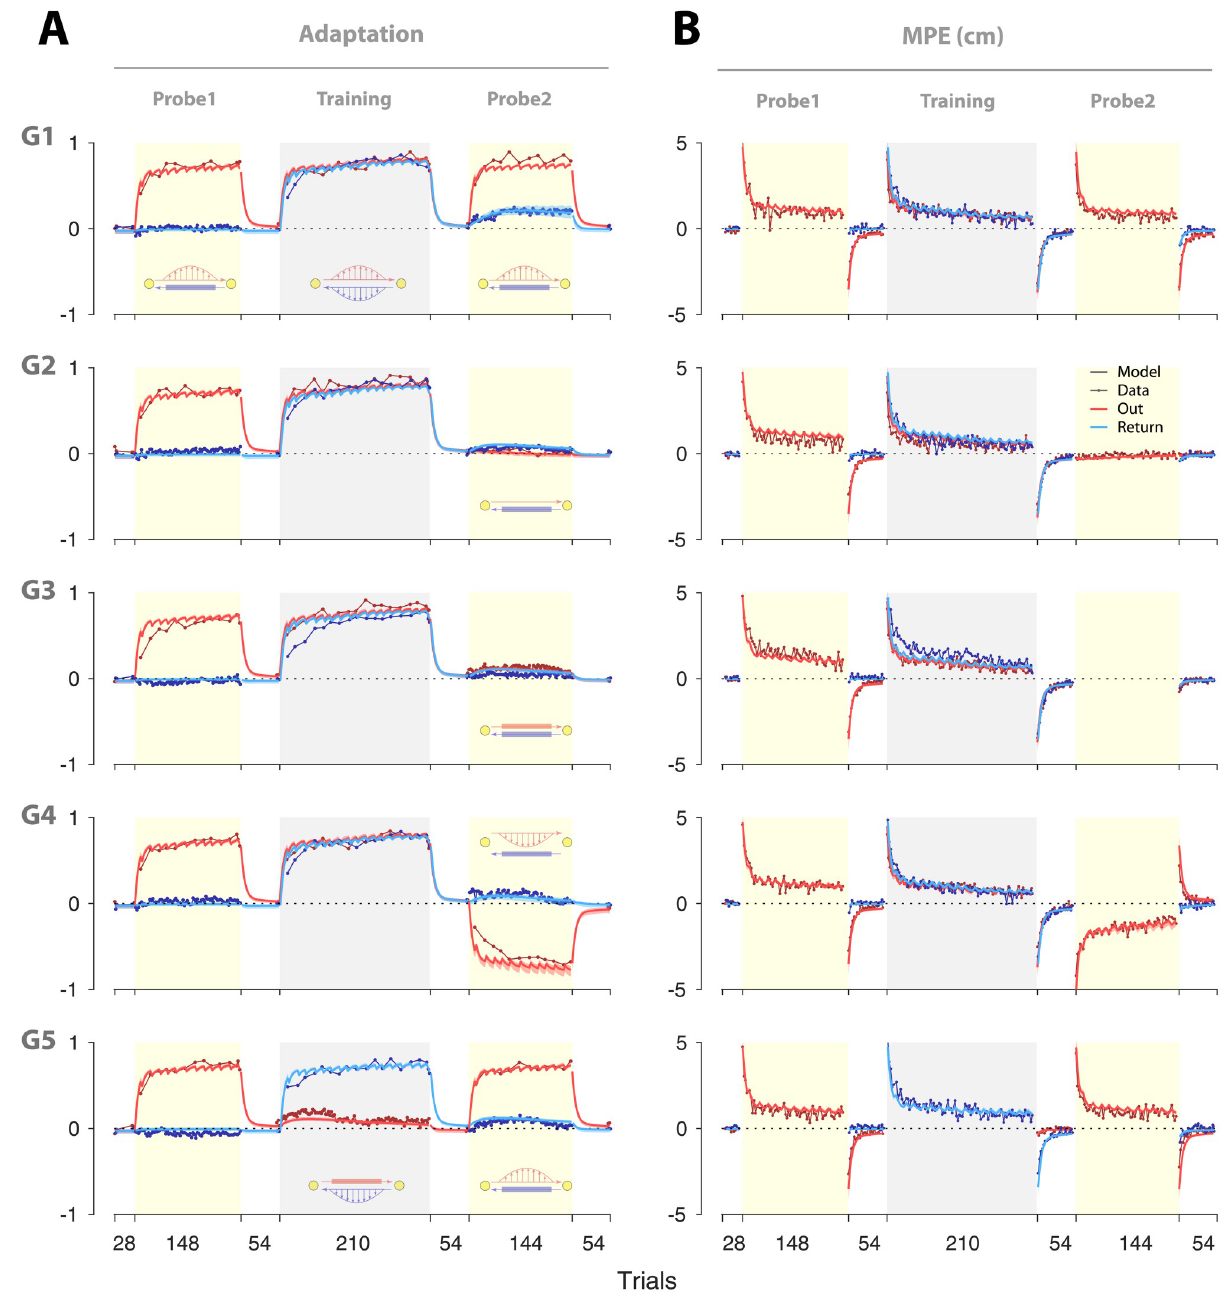
Fig 6. Model fits across three phases for the five groups. Fits of the selected model (M8) to adaptation ( A ) and MPE ( B ). The model was fit to both measures (adaptation and MPE) concurrently for all groups. The solid lines show model fits to group data (red lines for Out and blue lines for Return movements) and the error bars (shading) represent the 95% confidence intervals on model fits from